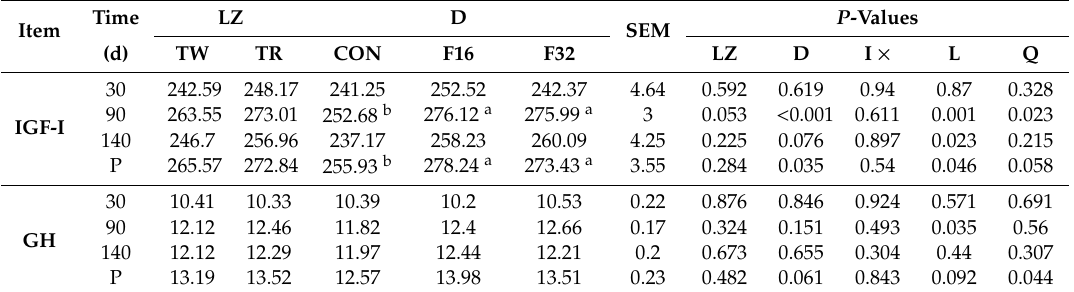
Table 3. The concentrations of IGF-I and GH a ff ected by litter size and dietary FA levels (ng / mL).